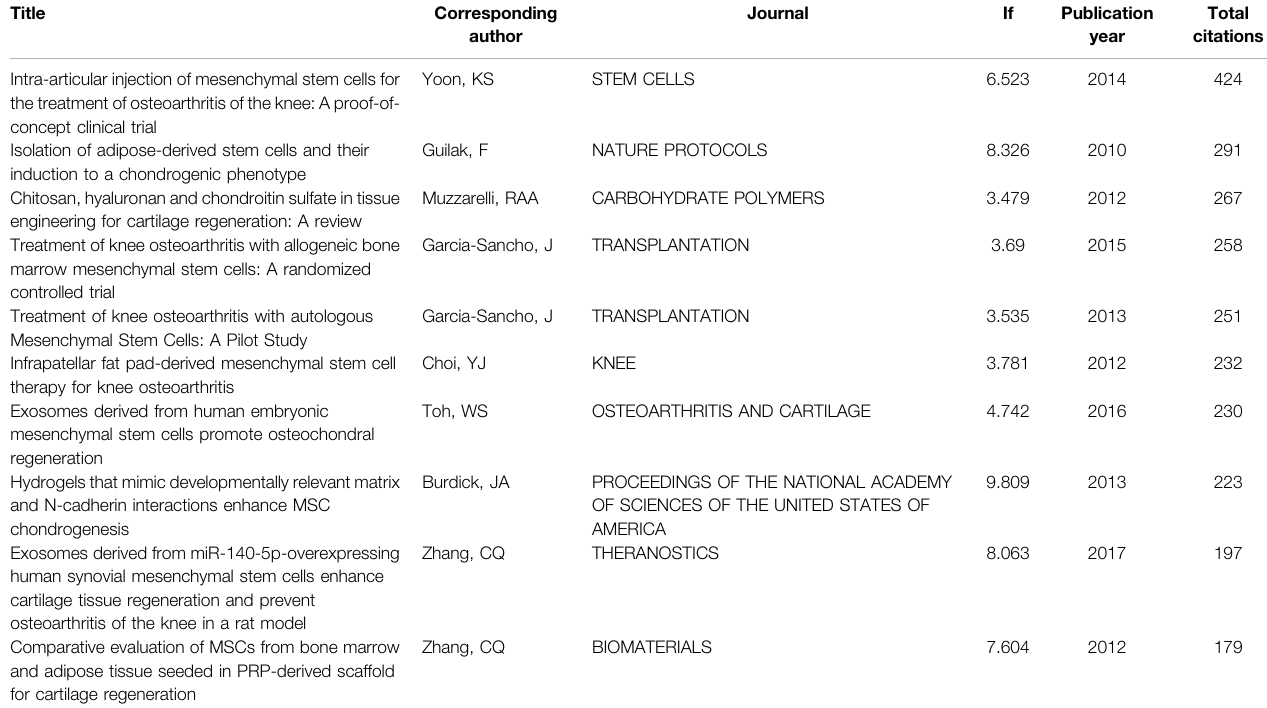
TABLE 4 | Top 10 references with the most citations in the fi eld of stem cells for cartilage regeneration.